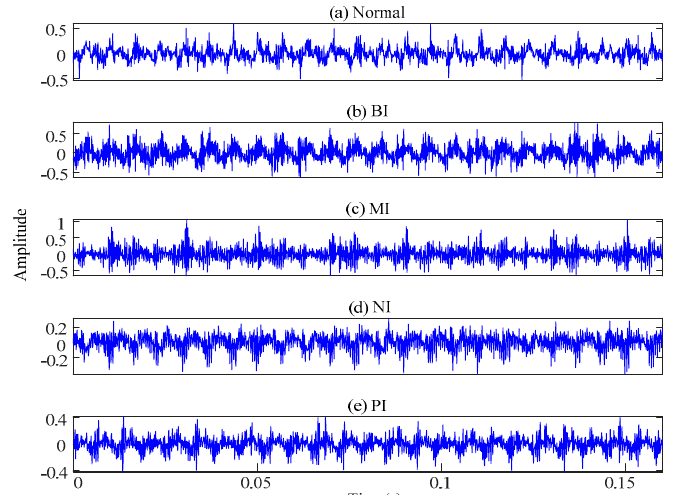
Figure 15. The time domain waveforms of rotating machinery in Experiment 2: ( a ) health condition (Normal), ( b ) broken tooth in the driving tooth with inner race fault (BI), ( c ) missing tooth in the driving tooth with inner race fault (MI), ( d ) health tooth in the driving tooth with inner race fault (NI), ( e ) pitting in the driving tooth with inner race fault (PI). Table 3. Detailed information of five conditions in Experiment 2.